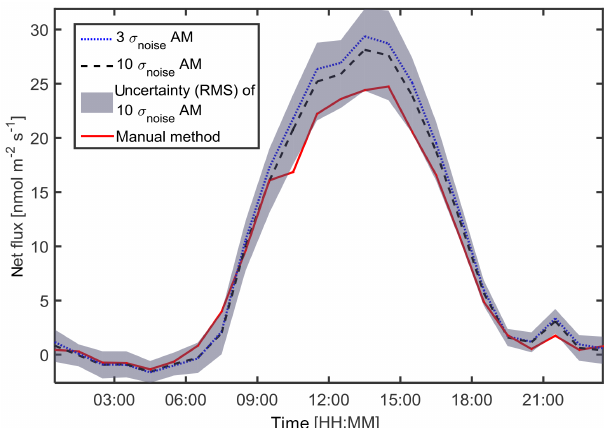
Figure 5. Diurnal net flux of the automated method (AM) with 3 and 10 σ noise threshold for the flux calculation and the manual method. The uncertainty (root mean square) was calculated for the automated method with 10 σ noise . The time is in CET